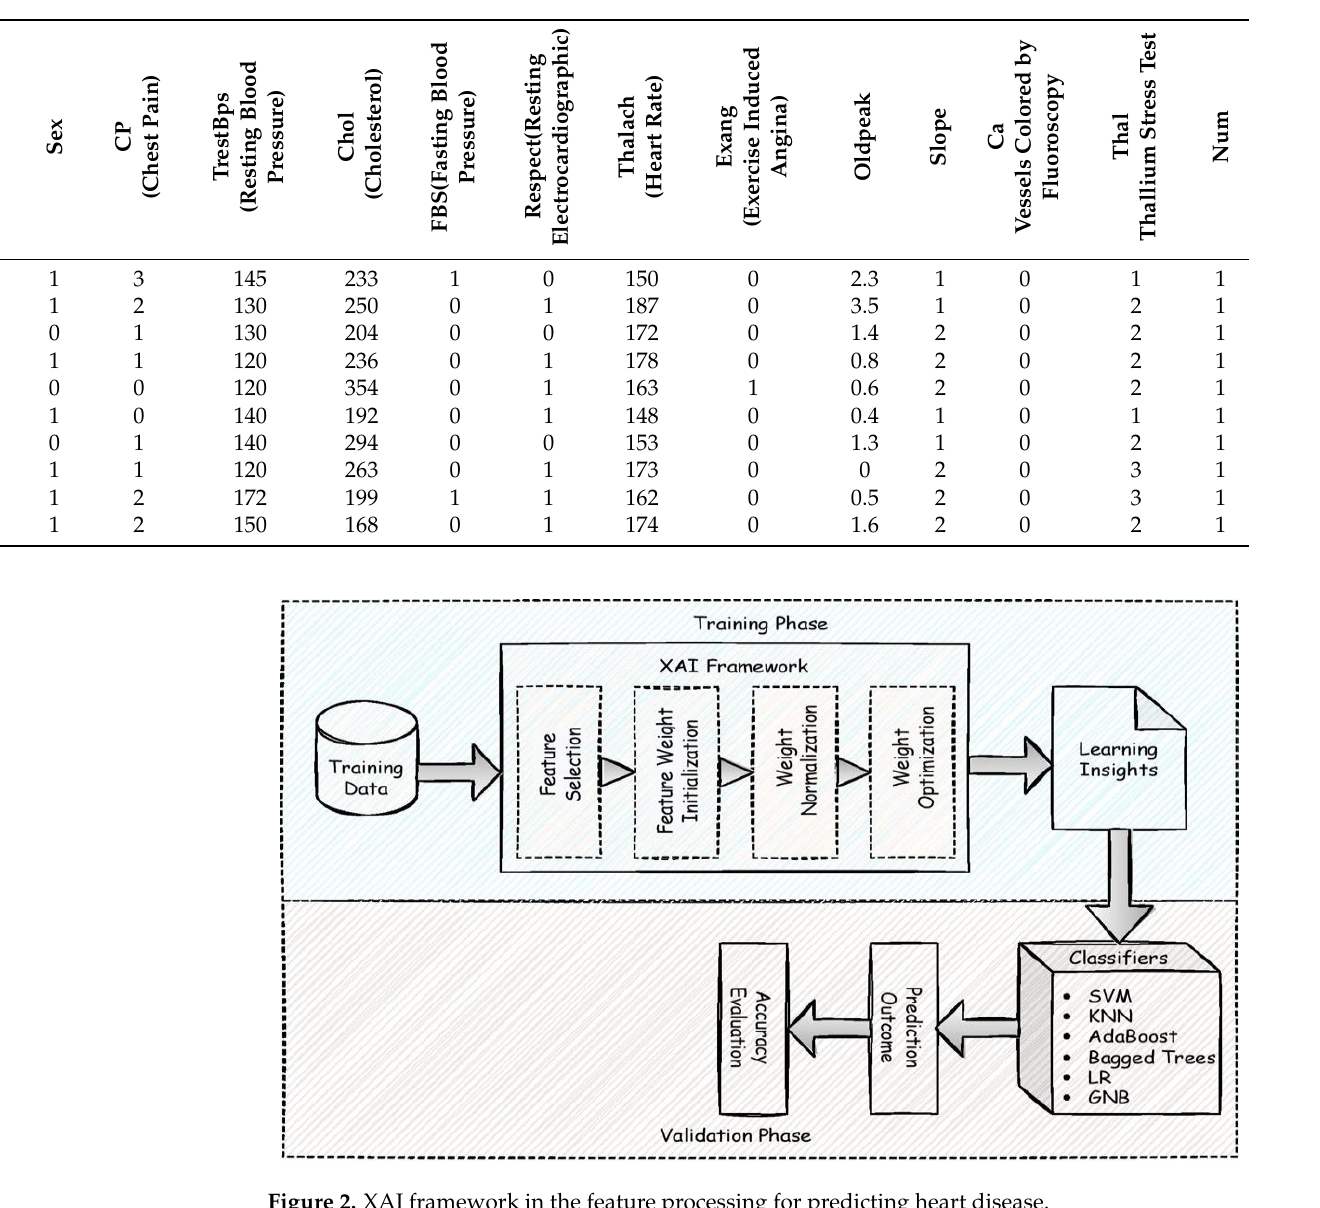
Table 1. Sample records associated with the dataset used in the current study.